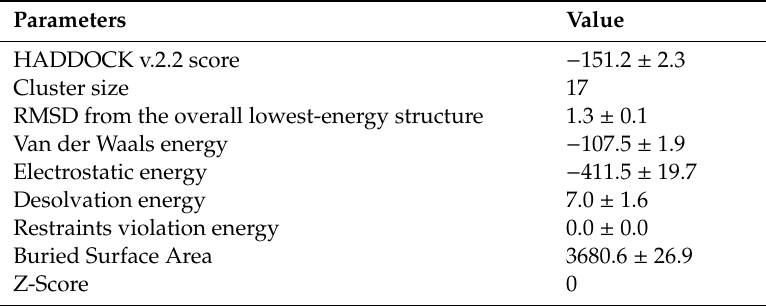
Table 4. Statistics of top the TLR3-MEV docked